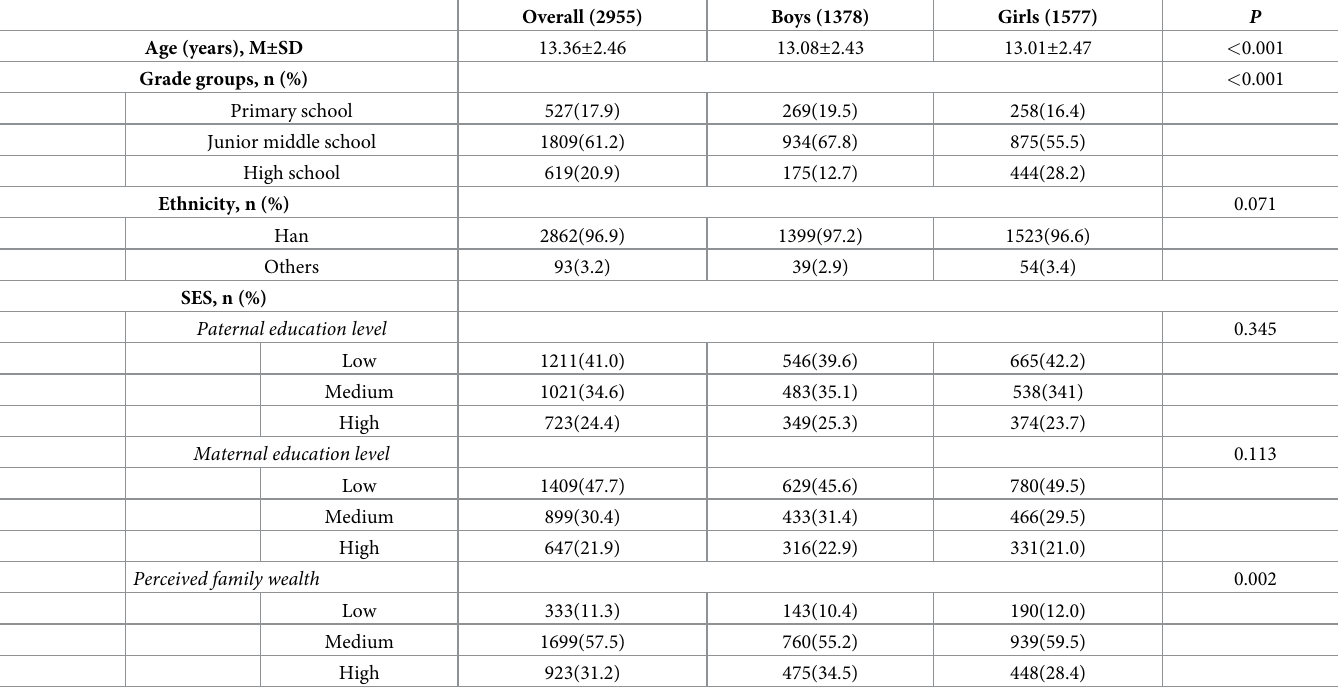
Table 1. The characteristics of the samples.